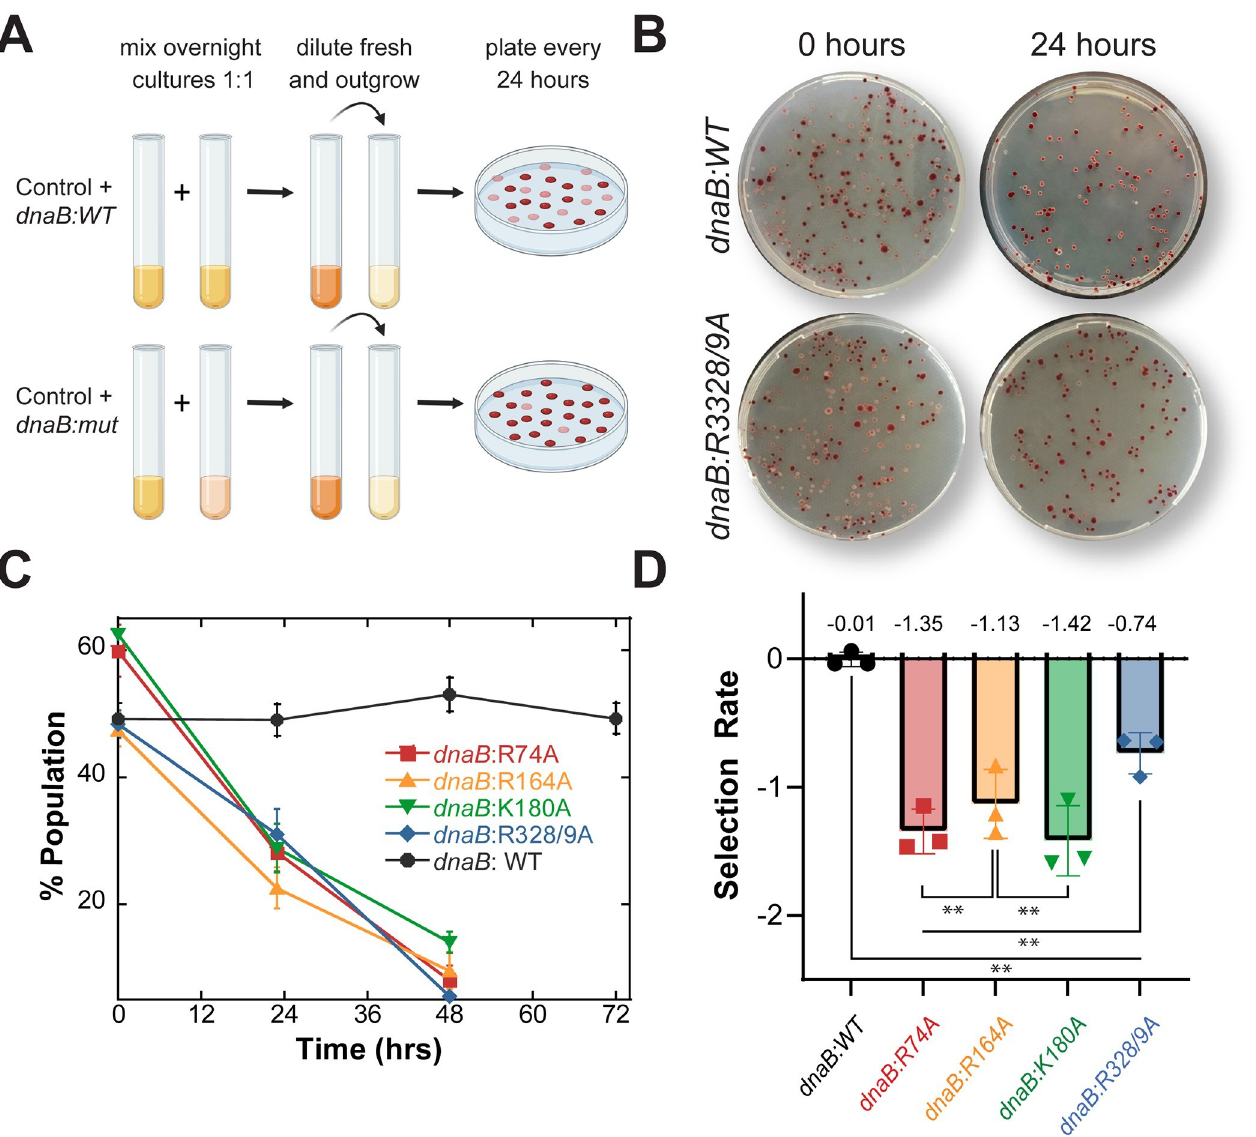
Fig 3. dnaB mutations reduce strain fitness. ( A ) Schematic for a red-white bacterial competition assay, where strains are color coded for colorimetric differentiation over time. Red is the control strain MSB1, and white are the test strains. ( B ) Representative plates showing changes in population overtime for the equally mixed populations MSB1 versus dnaB : WT or dnaB : R328/9A at 0 and 24 hours. ( C ) Changes in population of mixed cultures are plotted over time for n = 3 biological replicates with error bars representing the standard deviation. ( D ) The mean selection rate for each strain based on the population change during the first 24 hours ( Eq 4 ). Individual data is presented with open circles. Black bars indicate statistically significant differences. Selection rate is a relative determination of strain fitness compared to the control strain, MSB1. Error bars represent ± SD and are within symbols where not visible. Black bars indicate statistically significant differences, where p-values are � < 0.05 and �� <